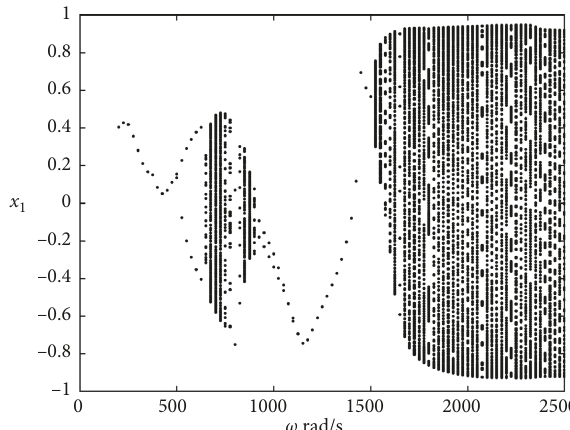
Figure 7: Bifurcation diagram of the rotor system in the x rection when b 1 �